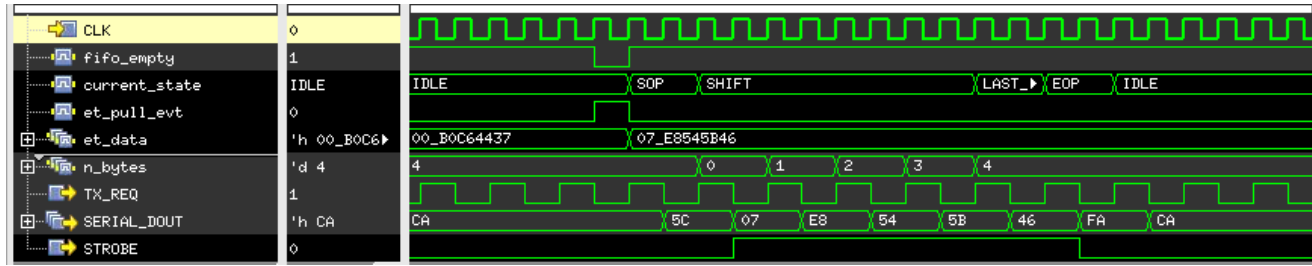
Figure 8. Event Transmitter chronogram example (1 event sent). Start-of-Packet = 0 × 5C, End-of-Packet = 0 × FA, Idle byte = 0 × CA.